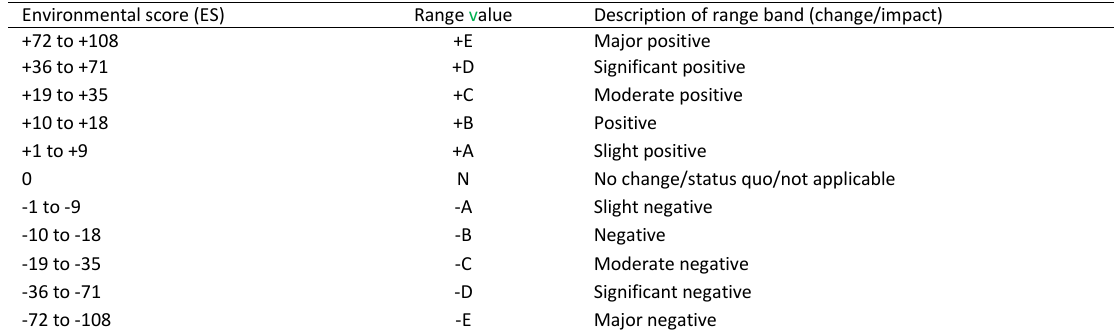
Table 7: Converting given scores to the range of categories